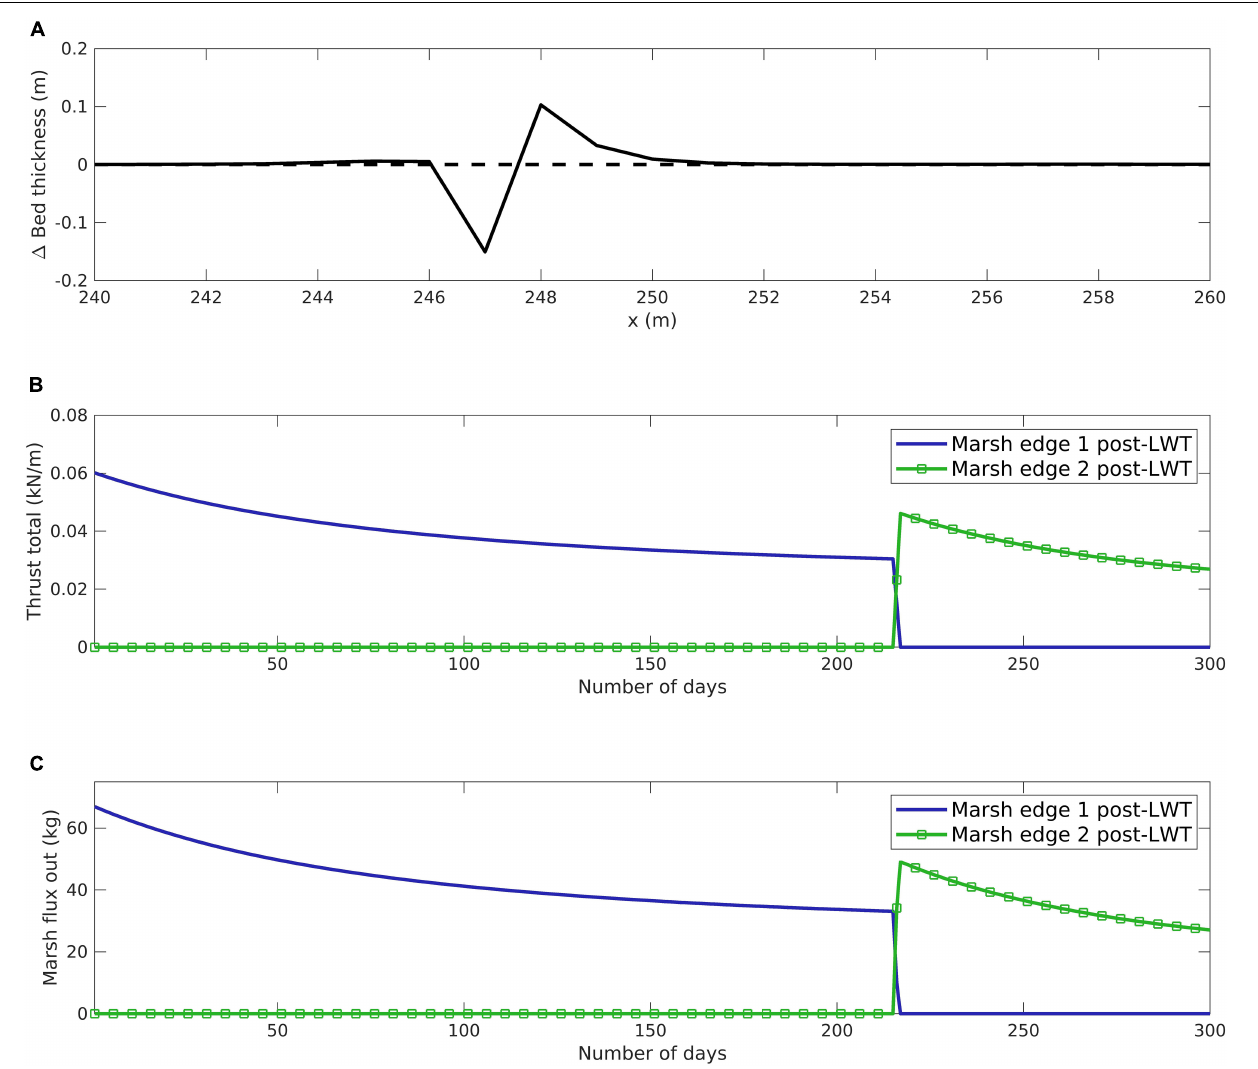
FIGURE 6 | Marsh shoreline erosion results from high resolution (1 m) idealized domain: (A) Initial and final bed thickness change at a cross-section. (B) Averaged daily lateral wave thrust on marsh edge. (C) Averaged daily flux of sediment out of the marsh edge cells.